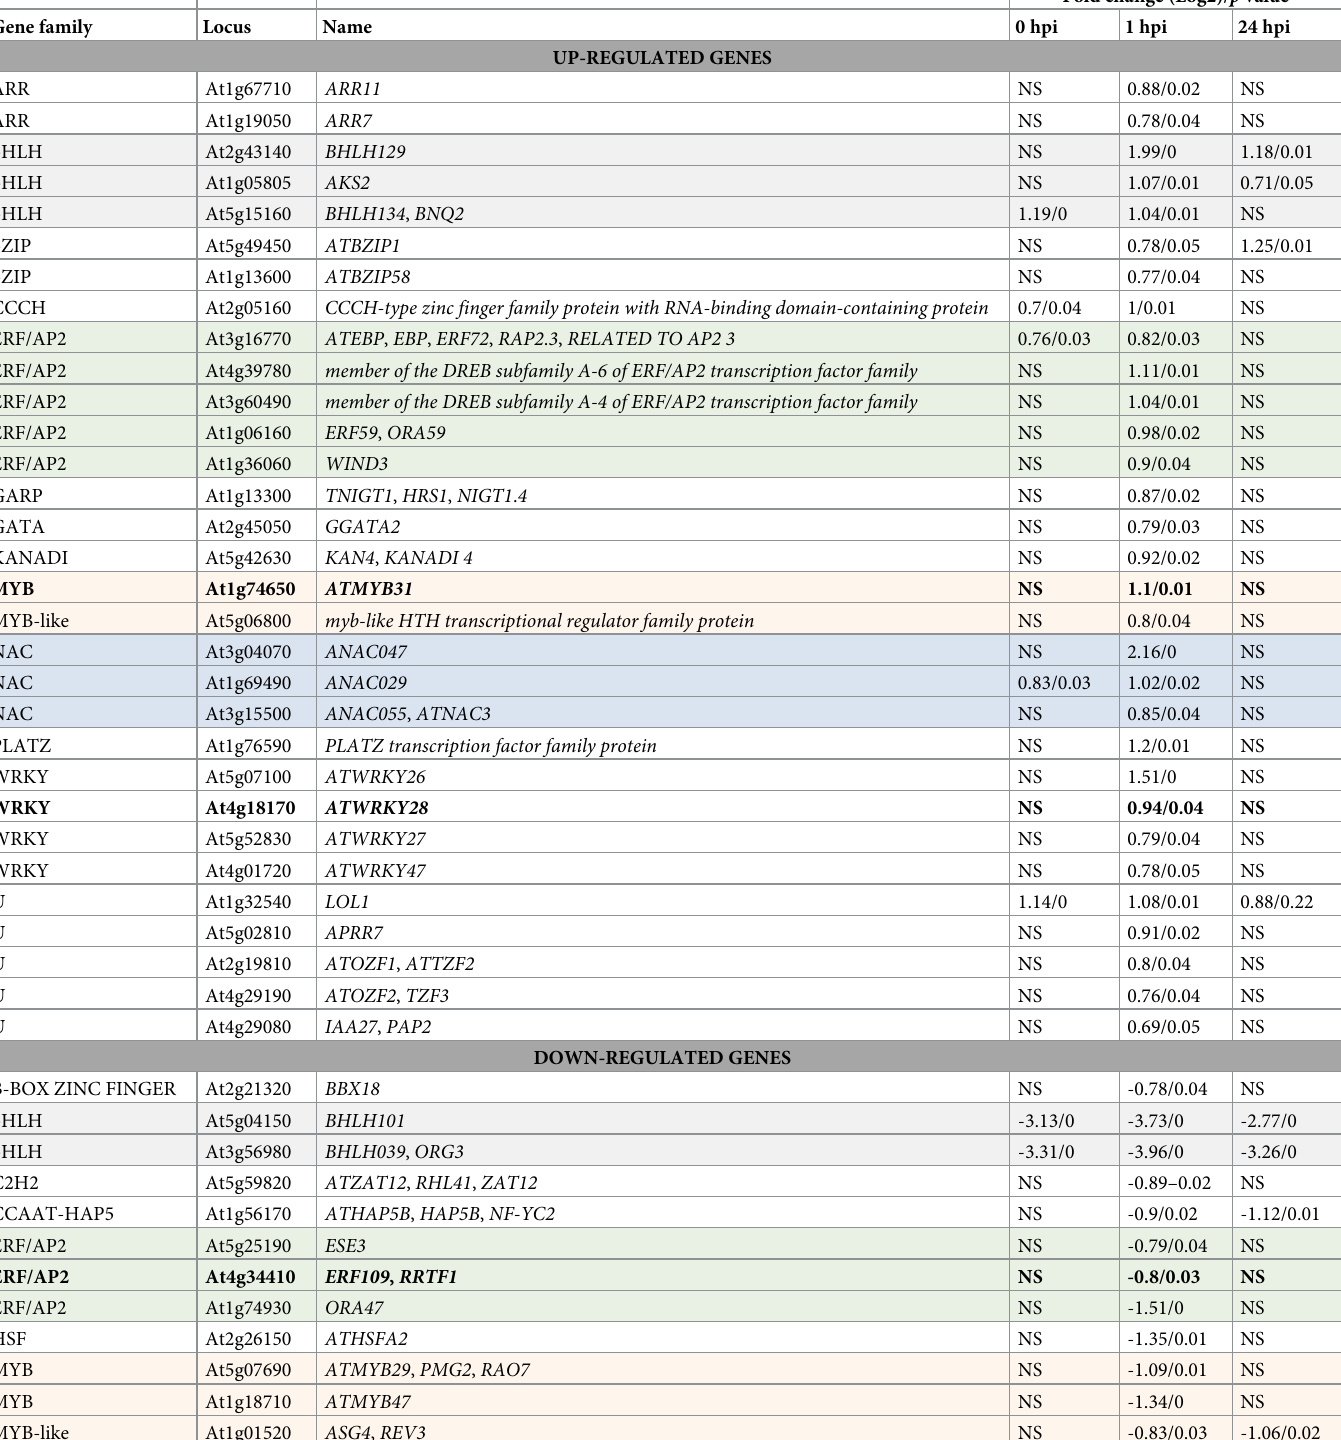
Table 1. Transcription factors coding genes regulated by Paraburkholderia phytofirmans PsJN at 1 hour post infection (hpi) with Pseudomonas syringae Pst DC3000 in Arabidopsis thaliana plants , and their fold changes and p- values before the infection (0 hpi) and at 24